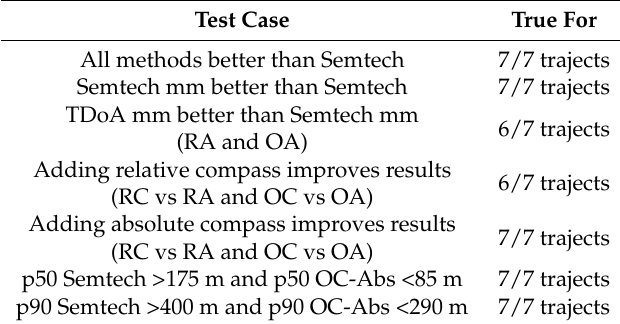
Table 6. General